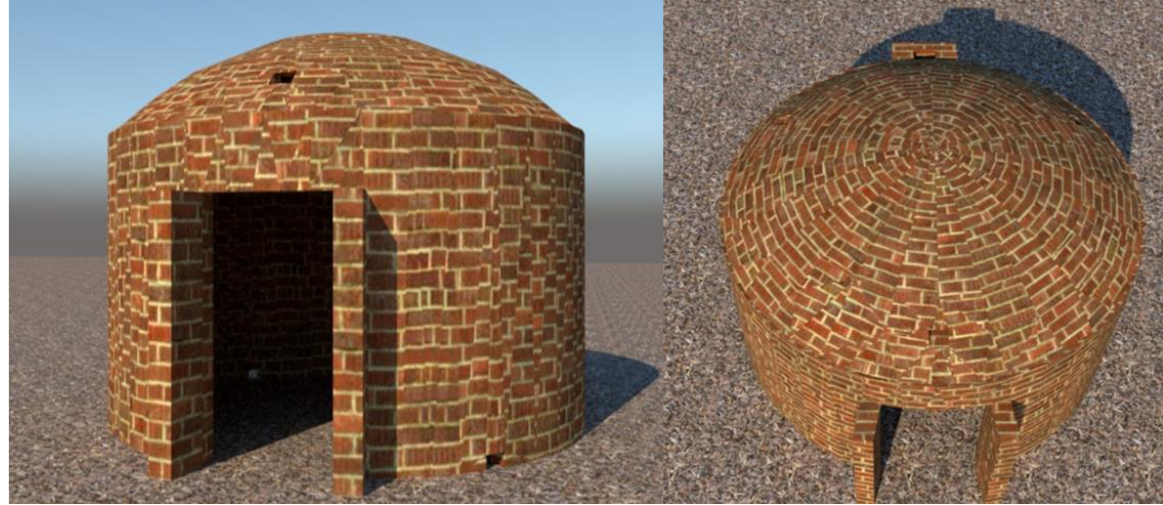
Figure 3. Design of a modified Brazilian beehive type kiln.